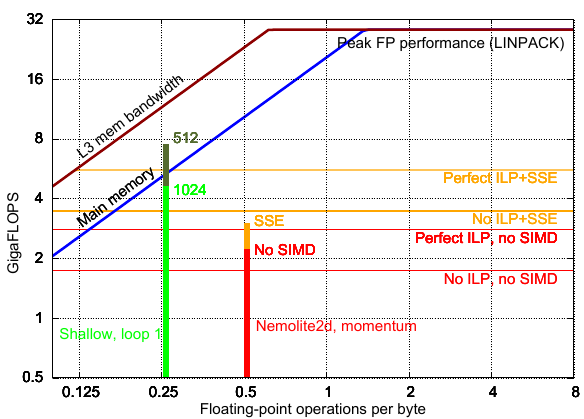
Figure 13. Comparison of the performance achieved by kernels from NEMOLite2D and Shallow on a roofline plot for the E5-1620 CPU. Results for the former are for the 256 2 domain since that gave the best performance. See the text for a discussion of the different CPU ceilings (coloured, horizontal